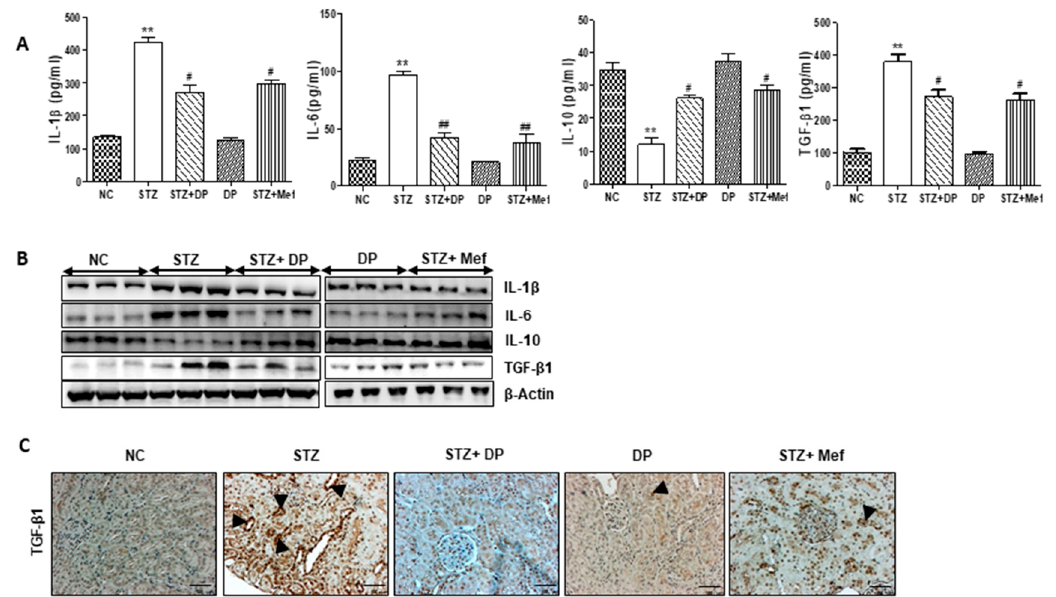
Figure 6. E ff ect of DP extract on inflammatory cytokines levels in the serum of STZ-induced diabetic rats. ( A ) Serum levels of cytokines were measured using assay kits. Data are expressed as the means ± S.D. of duplicate experiments (6 animals / group). Statistical analysis was performed by one-way ANOVA followed by Tukey’s HSD post hoc test for multiple comparisons. ** p < 0.01 compared to control group; # p < 0.05 and ## p < 0.01 compared to STZ-treated group. ( B ) Expression of interleukin (IL)-1 β , IL-6, IL-10, and TGF- β 1 was measured in the kidney of STZ-induced diabetic rats by Western blot analysis. β -Actin expression was used as the loading control. The Western blot results are representative of three separate experiments. ( C ) Representative immunohistochemical staining of transforming growth factor- β (TGF- β 1) in the kidney of STZ-induced diabetic rats. Black arrows represent TGF- β 1 expression. Original magnification: 100 ×.